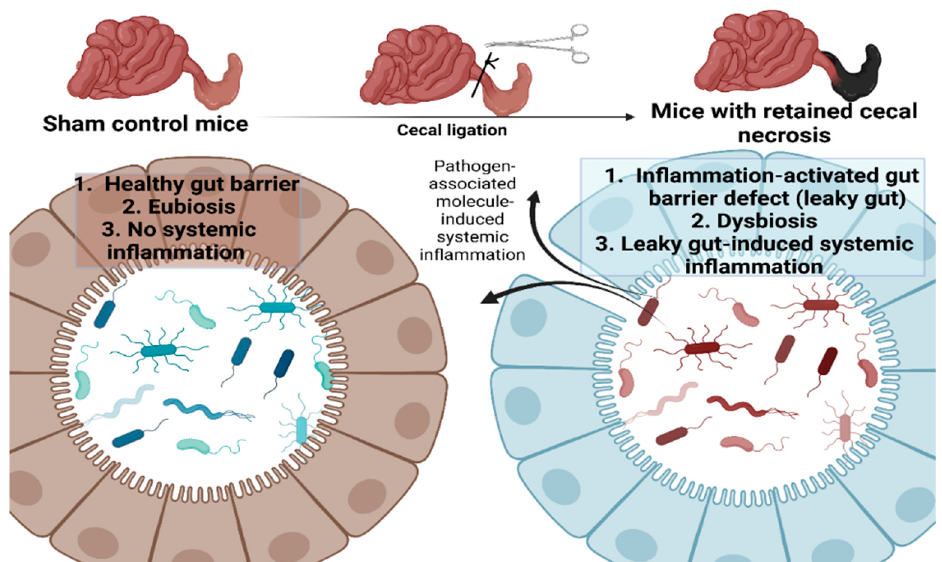
Figure 5. The proposed working hypothesis of the gut barrier defect (leaky gut) from the retained necrotic lesion in the abdomen possibly through the active intraperitoneal inflammation that induces fecal dysbiosis (prominence in Proteobacteria ; the phylum of several Gram-negative pathogenic bacteria) leading to the translocation of microbial molecules from the gut into the blood circulation (leaky gut) that facilitating systemic inflammation is demonstrated. Picture created by BioRender.com.